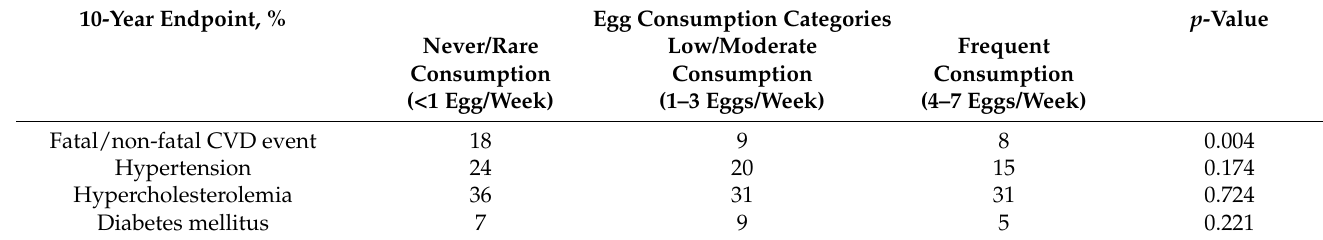
Table 2. Ten-year incidence of first fatal/non-fatal cardiovascular disease incidence and intermediate cardiometabolic conditions according to egg level of consumption, in the ATTICA study participants ( n =